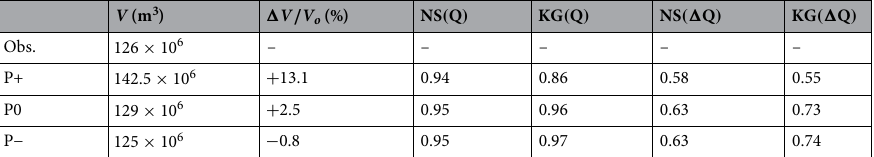
Table 2. Summary of discharge volumes, NSE (NS) and KGE (KG) for the observed discharge data and the simulations. (cid:31) V denotes the difference in discharge volumes with respect to the observed discharge volume and V o is the observed discharge volume.